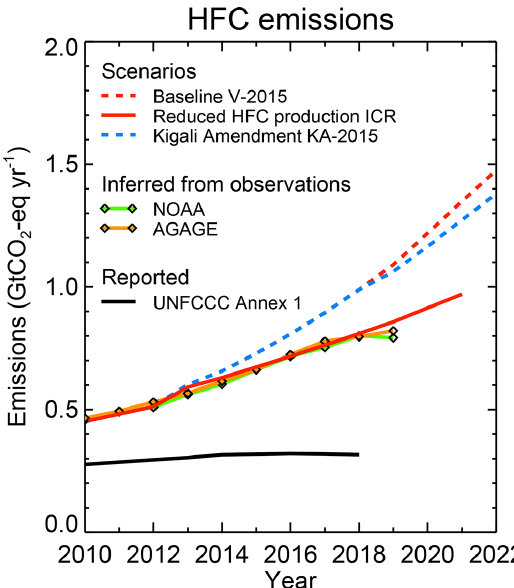
Figure 1. Global total HFC emissions (GtCO 2 eq . yr − 1 ) from the baseline scenario (V-2015), the Kigali Amendment scenario (KA- 2015), and inferred from observed mixing ratios from the AGAGE and NOAA networks (see Sect. 2). The solid line shows an adjusted scenario with reduced HFC consumption for industrial and com- mercial refrigeration (ICR) from 2013 onward. The curves contain the contributions from all HFC emissions, except HFC-23. The sce- narios were constrained by the emissions inferred from observed mixing ratios up to 2013. Also shown are the emissions reported to the UNFCCC by developed (Annex 1) countries. AGAGE global annual means are estimated from observations at Mace Head (Ire- land), Trinidad Head (Barbados), Ragged Point (Barbados), Cape Matatula (American Samoa), and Kennaook / Cape Grim (Tas- mania). NOAA global annual means are estimated from measure- ments from flasks collected at Alert (Canada), Barrow (Alaska), Ni- wot Ridge (Colorado), Mauna Loa (Hawaii), Kumukahi (Hawaii), American Samoa, Kennaook / Cape Grim (Tasmania), and the South Pole. See Fig. S2 in the Supplement for the mixing ratios of the 10 individual